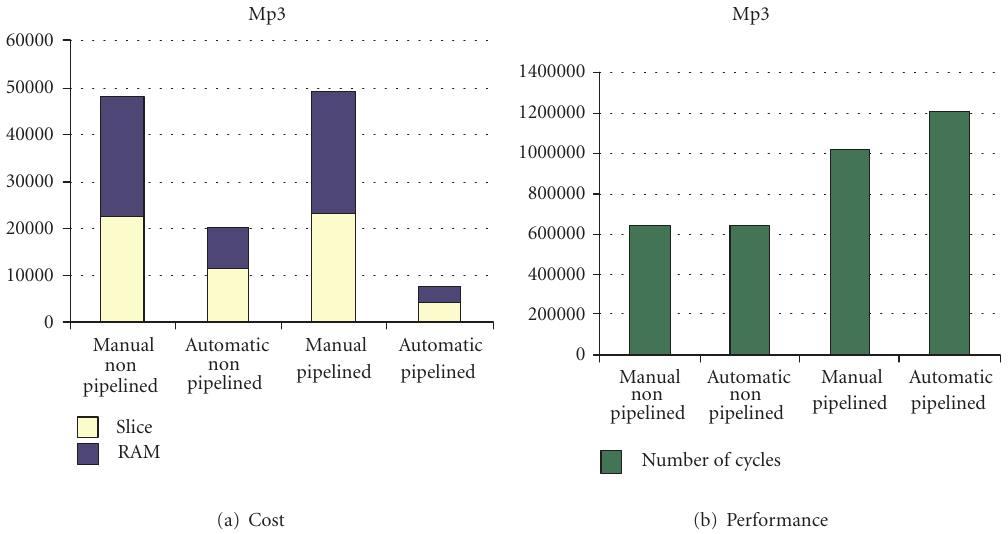
Figure 18: Mp3: number of slices, number of RAMs, and number of cycles for manually selected and automatically generated data